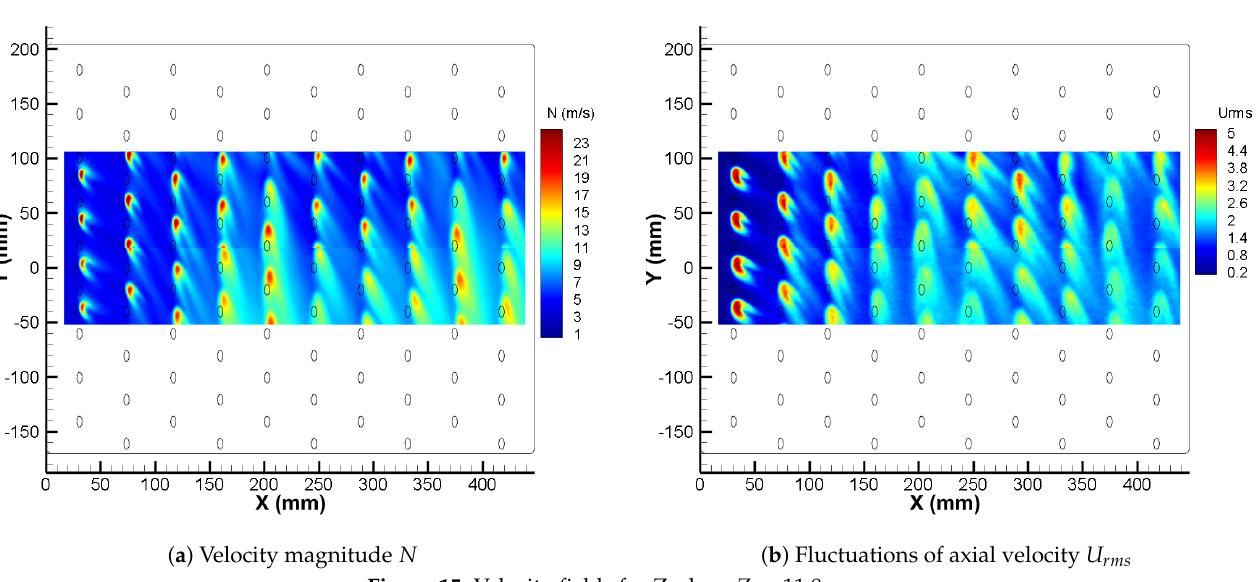
Figure 15. Velocity fields for Z-plane Z = 11.8 mm.